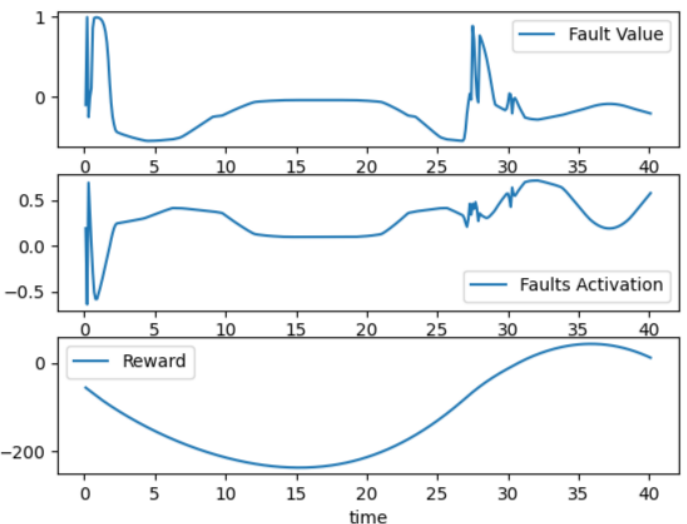
Figure 8. Fault value and activation time of trained agent.